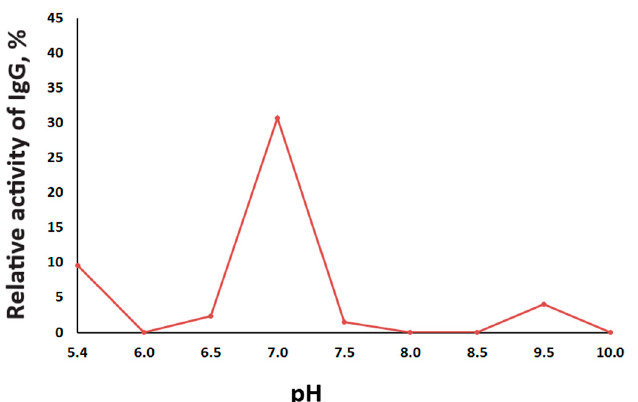
Figure 4. The pH dependence of the relative proteolytic activity of IgGmix in the hydrolysis of MBP. The relative proteolytic activity corresponding to complete hydrolysis of MBP after 20 h of incubation with 0.2 mg/mL IgGmix was taken as 100%.